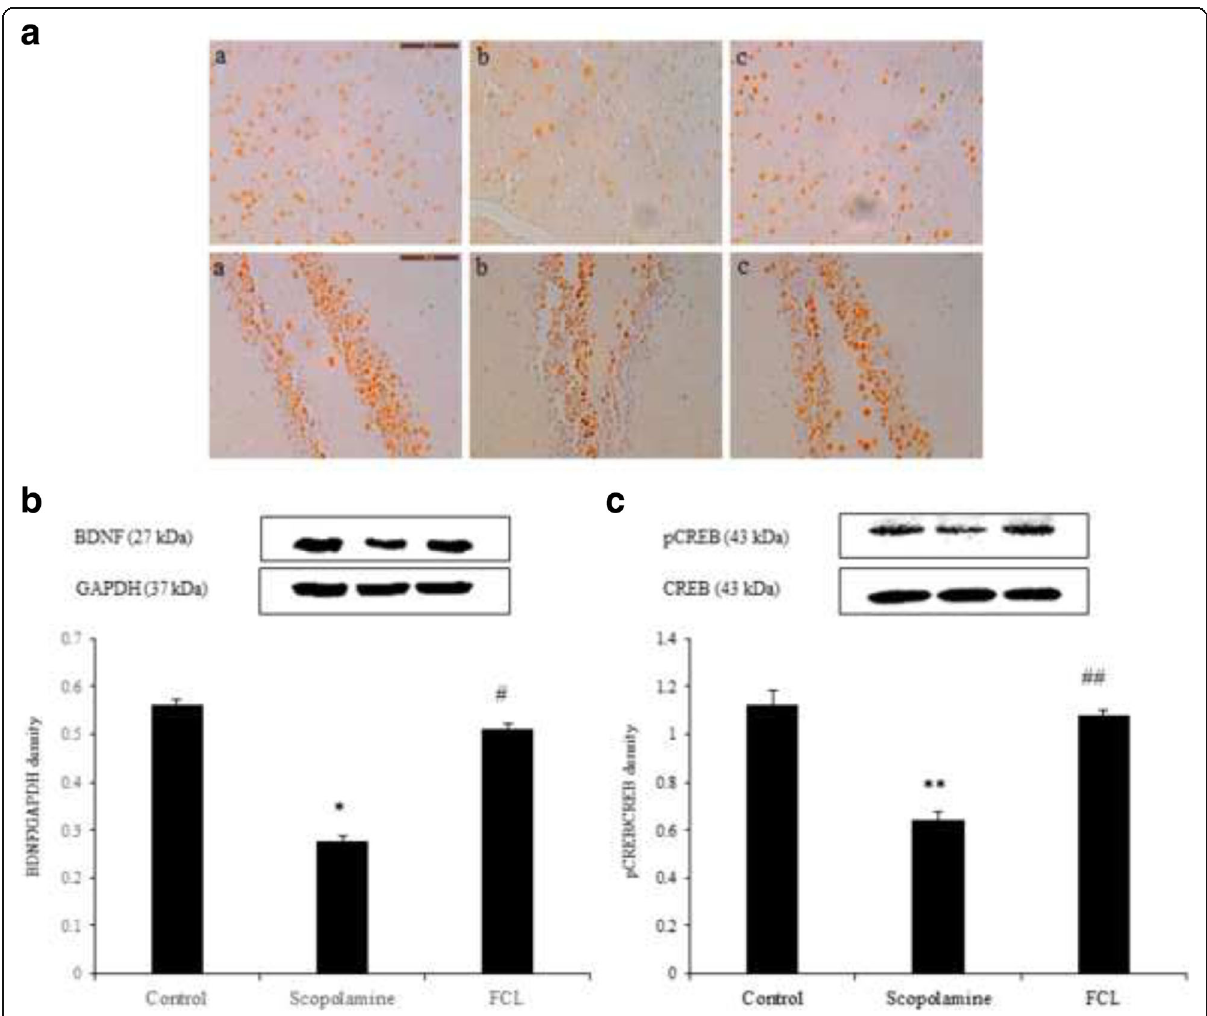
Fig. 5 Effects of FCL on pCREB and BDNF in cortex and hippocampus of scopolamine-induced memory deficit. Photomicrographs ( a ) showing the pCREB immunoreactivity in sections of cortex and the dentate gyrus region of hippocampus. Original magnification was 40× (a-c ). Scale bar = 50 μ m. The expression levels were measured by Western blot analysis ( b, c ). The relative expression levels of BDNF (27 kDa) and pCREB (43 kDa) were determined by densitometry and normalized by internal controls, GAPDH (37 kDa) and CREB (43 kDa). Data represent means ± SEM ( n = 3). * P < 0.05, ** P < 0.01 as compared with the control group, # P < 0.05, ## P < 0.01 as compared with the scopolamine